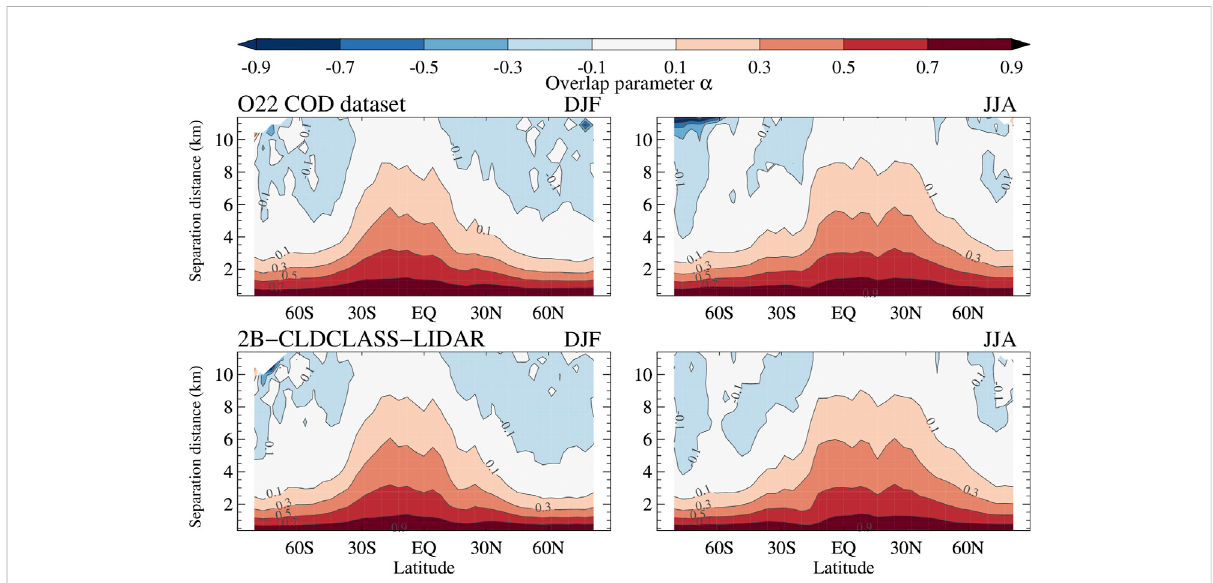
FIGURE 2 Zonal variation of mean α as a function of separation distance Δ z for DJF (December - January-February), left panels, and JJA (June-July- August), right panels. The upper panels come from calculations using the O22 COD fi elds and the bottom panels from 2B-CLDCLASS-LIDAR. The latitudinal resolution is 4 ° and the vertical resolution used for the plot is 480 m.